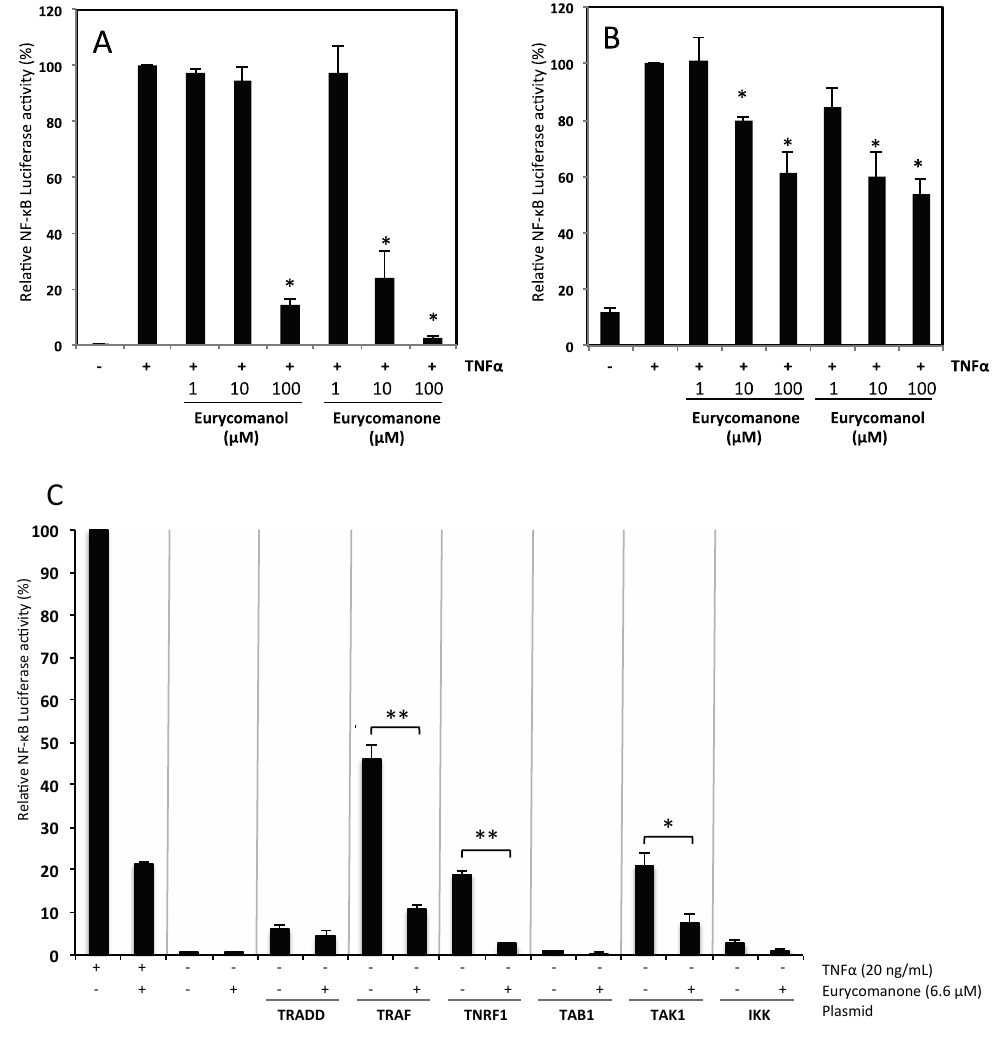
Figure 7. The effect of eurycomanone and eurycomanol on TNF α -induced NF- κ B transcriptional potential. K562 ( A ) and Jurkat ( B ) cells were transfected with a luciferase construct under the control of NF- κ B. Cells were pre-treated during two hours with compounds then treated, or not, with TNF α (20 ng/mL) for six hours. Each value is the mean ± SD of three independent experiments. * indicates a significant difference compared to the positive control (TNF α alone) analyzed by the t -test (* p < 0.05). ( C ) Co-transfection of K562 cells with an NF- κ B-regulated luciferase reporter construct together with TNFR1-, TRADD-, TRAF2-, TAK1-, TAB1- and IKK β -expressing plasmids. Each value is the mean ± SD of three independent experiments. The asterisk indicates a significant difference compared to the negative control analyzed by the t -test (* p < 0.05, ** p <